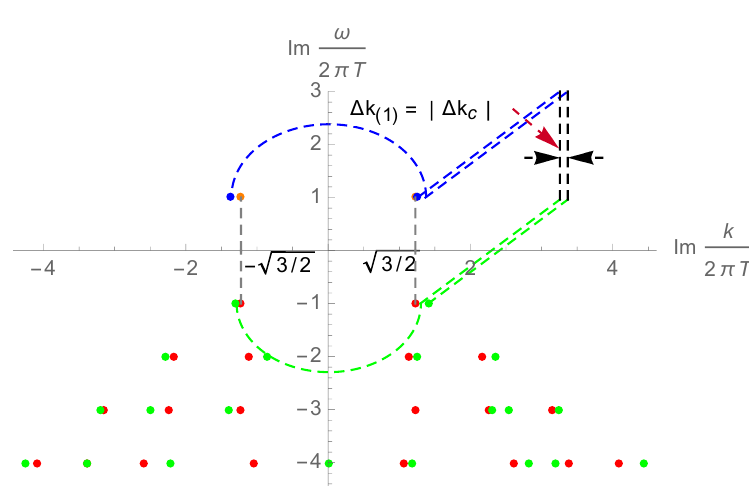
Figure 1 . Spectrum of chaos points (in the upper half plane) together with the pole-skipping points of a boundary operator dual to a scalar (cid:12)eld with mass m = 0 in the bulk (in the lower half plane). Orange and red points, which are symmetric with respect to the vertical axis, are related to non-chiral matter at (cid:23) = 0 and b = 0. Blue and green points, however, correspond to a chiral matter at (cid:23) = 0 : 5 and b = 0 : 5. Due to the chiral anomaly, these points are located asymmetrically p with respect to vertical axis. The vertical gray dashed lines at k = (cid:6) 3 = 2 show that at the special case when m = 0, accidentally, the chaos points and the lowest frequency pole-skipping points have the same wavenumbers at b = 0 and (cid:23) = 0.